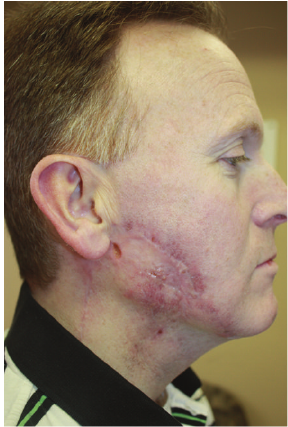
Figure 4: Case 4, eight weeks after initial flap reconstruction and now receiving interferon alpha-IIB therapy. Despite severe neu- tropenia,fullepithelializationoccurredwithin6weeksofMatriStem